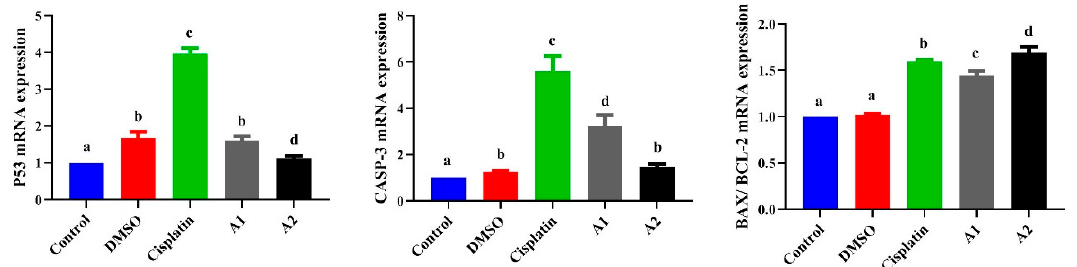
Figure 9. The fold change of p53 , CASP-3 and BAX/BCL-2 ratio of control and treated AML cells’ mRNA expression after 3 h of incubation. Data represent the average of three independent experi- ments (n = 3). Bars: standard deviation. Columns with different letters are statistically significant ( p < 0.05). CASP-3 : Caspase-3; A1: A. hierochuntica methanolic extract (0.5 µ g/mL); A2: (3.0 µ g/mL); cisplatin: (3.0 µ g/mL).